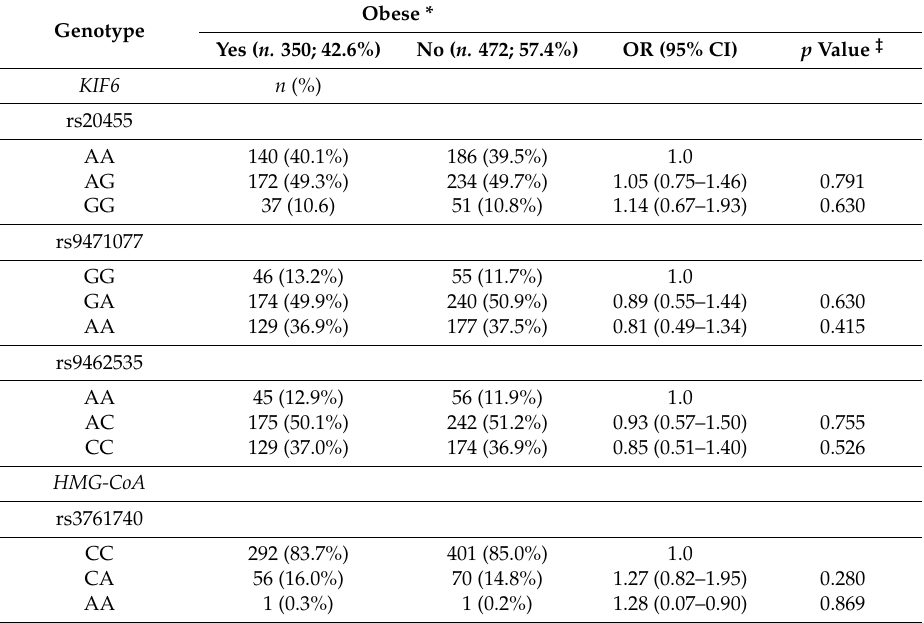
Table 6. Influence of KIF6 and HMG-CoA genotypes † on obesity, calculated according to waist circumference in